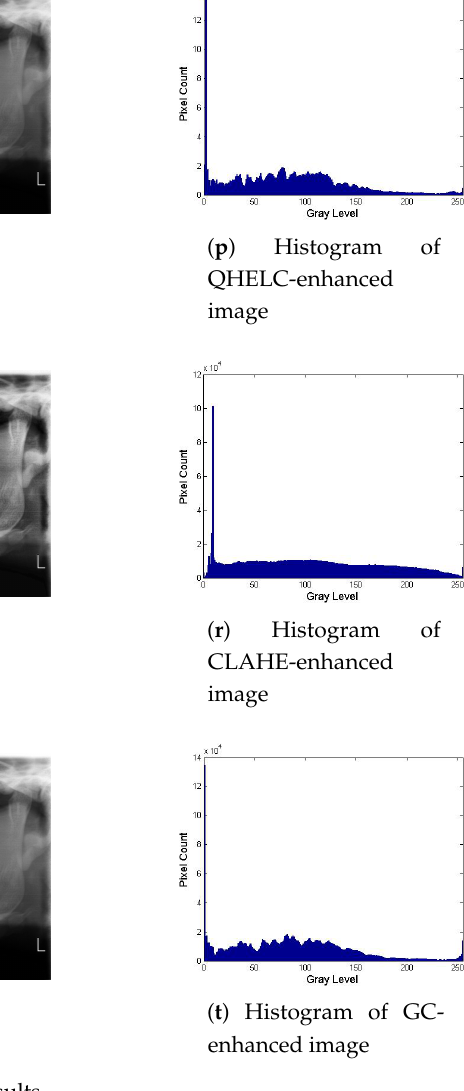
Figure 7. Visual